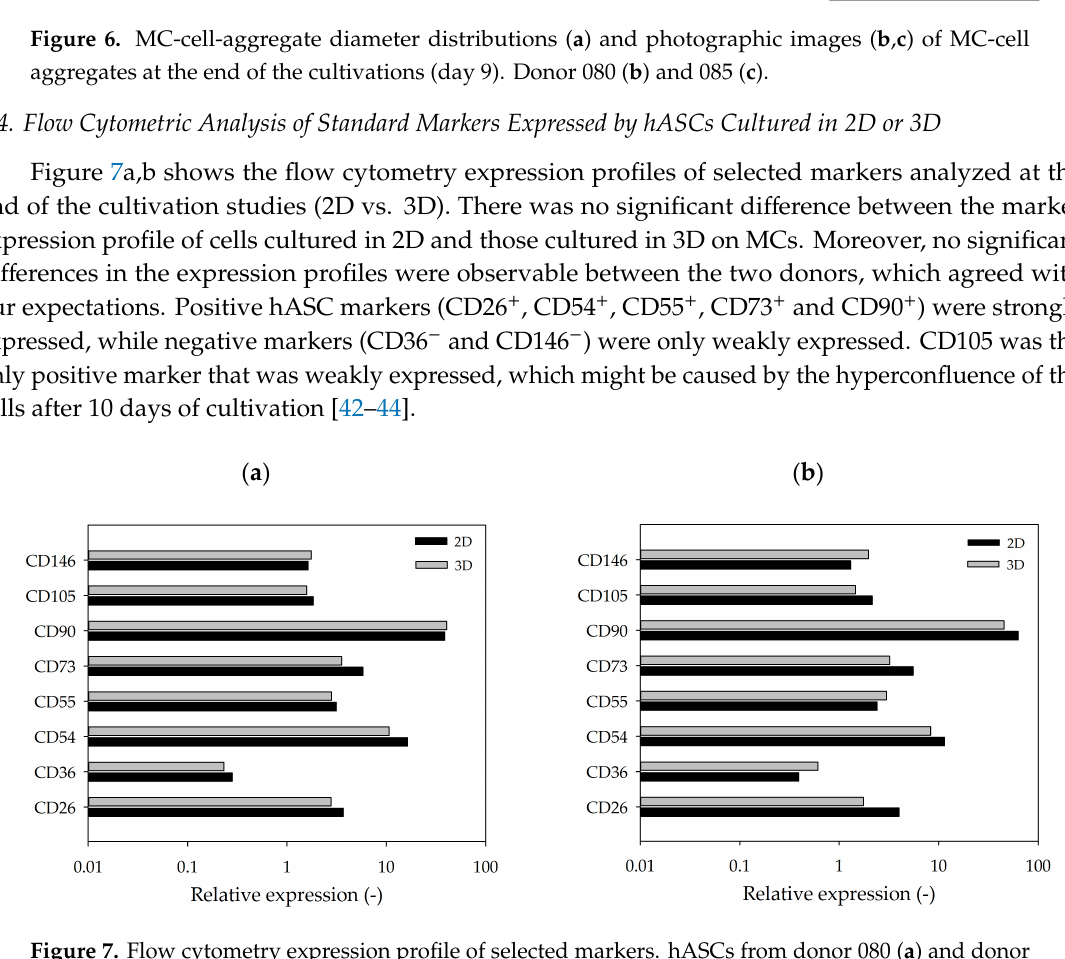
Figure 7. Flow cytometry expression profile of selected markers. hASCs from donor 080 ( a ) and donor 085 ( b ) cultivated in 2D (T 25 -flasks) or 3D (MC). hASCs were analyzed after harvesting on day 10. Mean fluorescence was calculated based on specific isotype controls (= relative marker expression).